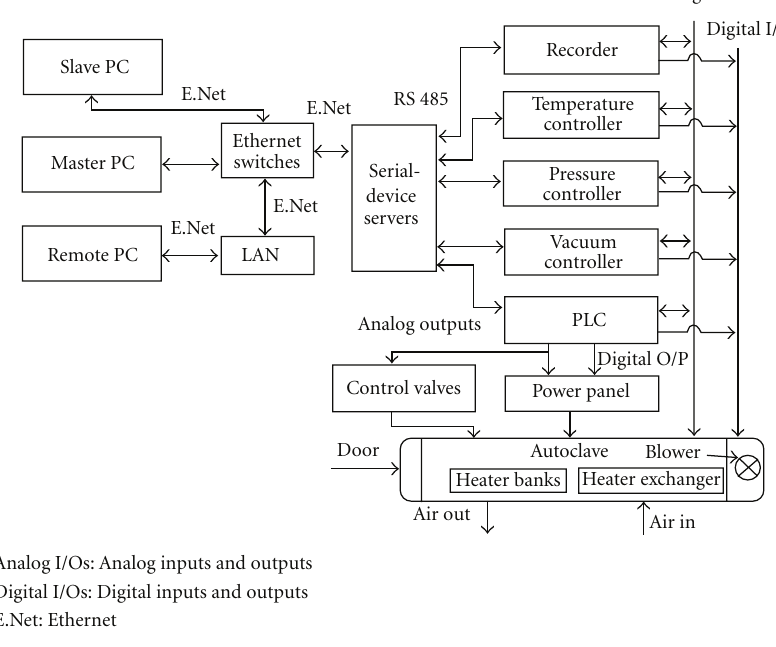
Figure 9: Architecture of the control